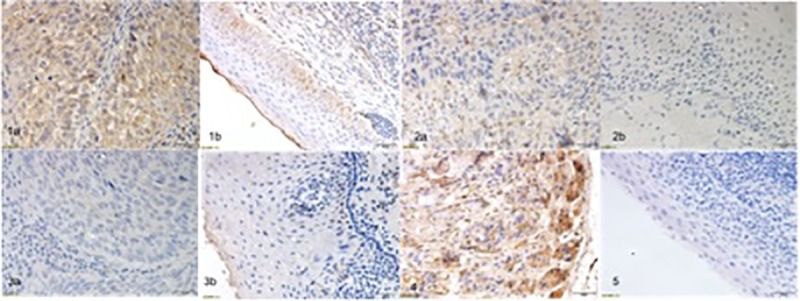
Pepsin staining in primary HPSCC tumors and matched adjacent tissues.Pepsin stained positively in HPSCC tumor 1a and matched adjacent tissue 1b. There was no pepsin in HPSCC tumor 3a and matched adjacent tissue 3b. Tumor 2a was positive but adjacent tissues 2b was negative, for pepsin staining. Gastric oxyntic mucosa (4) showed strong pepsin staining while tonsil (5) showed negative pepsin staining.